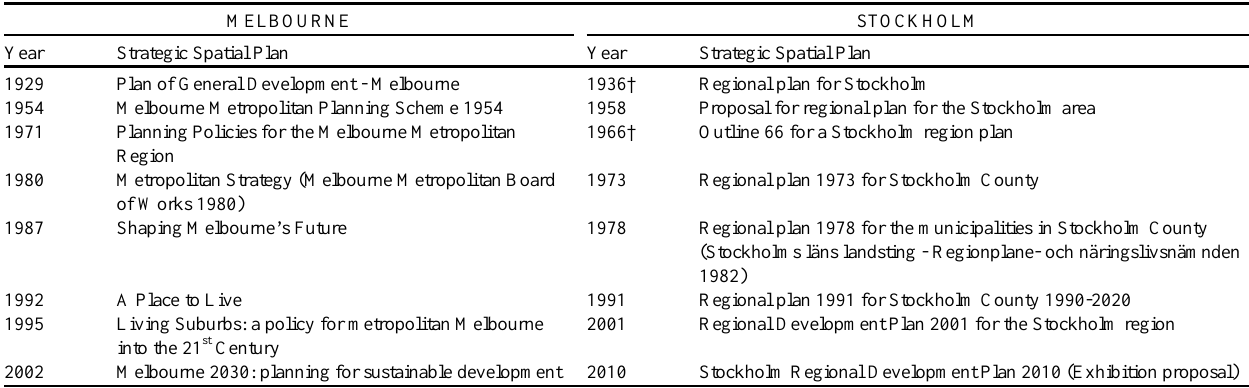
Table 1 . Strategic spatial plans included in